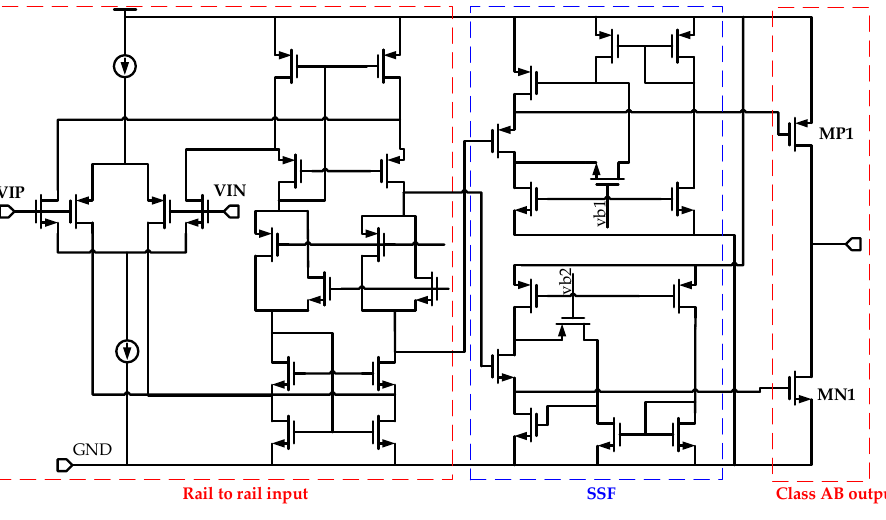
Figure 4. Detailed circuit of the LA.